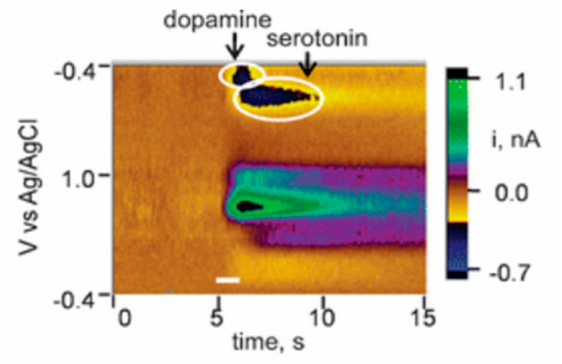
Figure 4. False color plot visualization of the change in concentration of dopamine and serotonin on single carbon nanotube. Reprinted with permission